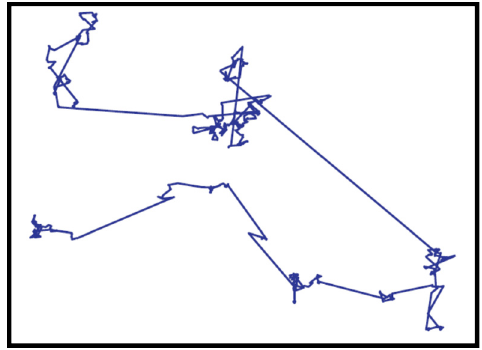
Figure 4. The le’vy flight works in a 2D plane.